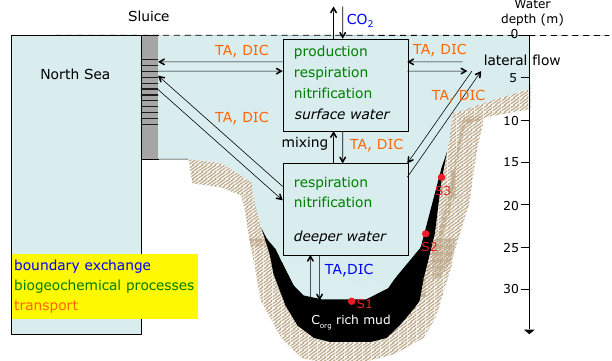
Figure 2. Schematic overview of the main processes affecting the Den Osse proton budget. C org refers to organic carbon; see Sect. 2.8 for a detailed explanation of the